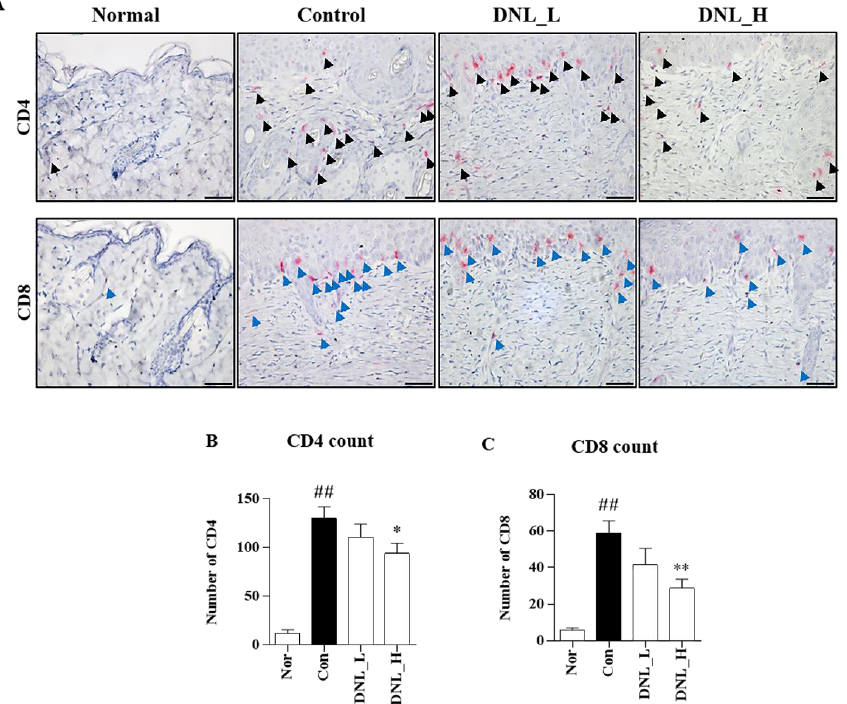
Figure 4. Effect of DNL in DNCB-induced Balb/c mice on CD4, CD8 T cell infiltration. ( A ) CD4 (black arrows) and CD8 (blue arrows) infiltration were confirmed in DNCB-induced Balb/c mice skin tissue by IHC (400×, scale bar 50 μm). ( B , C ) The numbers of CD4 and CD8 were counted and